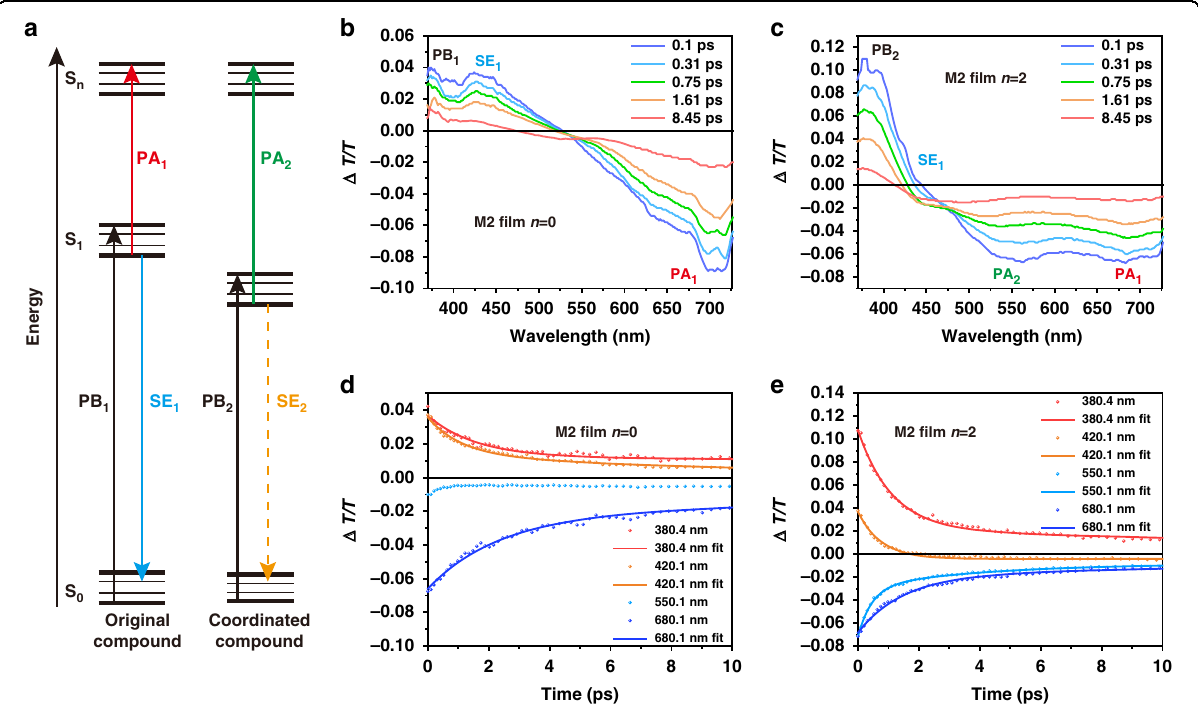
Fig. 4 The excited state behaviours of compounds in blending fi lms. a TA mechanism of original compound and coordinated compound in blending fi lms. b Δ T/T spectra of M2 with n = 0. c Δ T/T spectra of M2 with n = 2. d Δ T/T dynamics of M2 with n = 0 at different wavelength. e Δ T/T dynamics of M2 with n = 2 at different